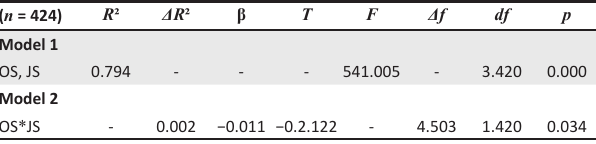
TABLE 7: The moderating role of job satisfaction on the relationship between occupational stress and organisational commitment.